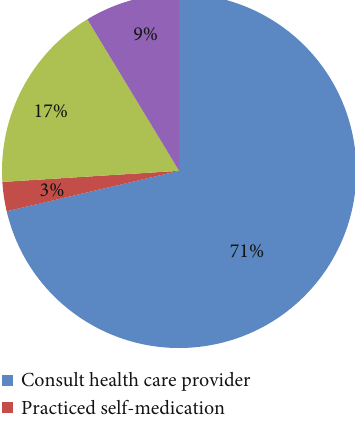
Figure 2: Proportions of patient ’ s fi rst action during the onset of TB symptoms at Debremarkos town public health facilities, North West Ethiopia,